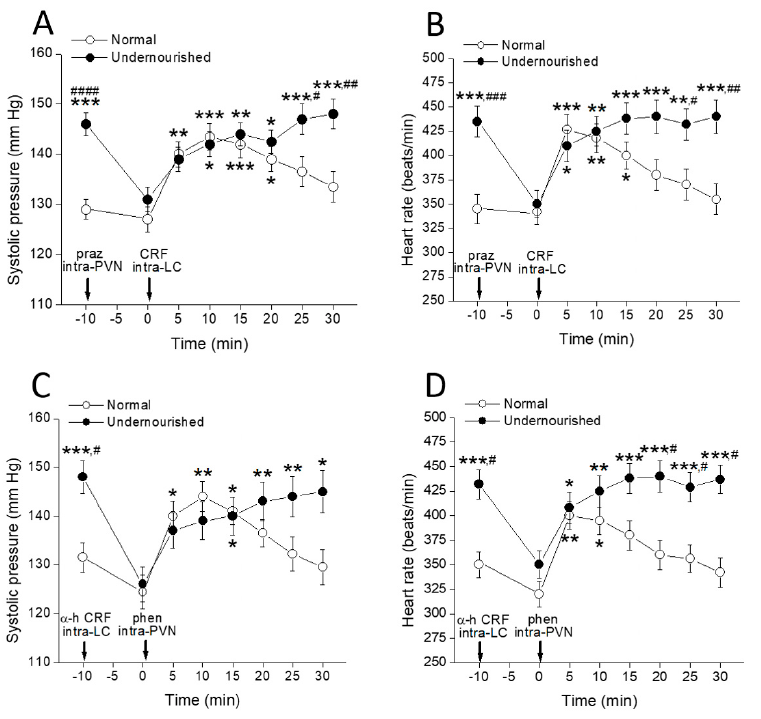
Figure 4. Time-course of changes in systolic pressure ( A , C ) and heart rate ( B , D ) of normal and prenatally undernourished rats after intra-PVN or intra-LC microinjection of phenylephrine (phen) or CRF (arrow at time 0 min), respectively, with or without pre-injection of an antagonist (praz or α -h CRF respectively, arrow at time − 10 min) into the complementary nucleus. Values are means ± SEM, n = six rats in each group. Two-way repeated measures ANOVA was used to identify the nutritional treatment and/or the time elapsed after drug microinjection as significant factors in the effect examined (( A ): effect on systolic pressure of CRF intra-LC preceded by prazosin intra-PVN, F nutrition(1, 10) = 28.02 and F time(7, 70) = 6.058; ( B ): effect on systolic pressure of phenyle- phrine intra-PVN preceded by α -helical CRF intra-LC, F nutrition(1, 10) = 15.90 and F time(7, 70) = 5.806; ( C ): effect on heart rate of CRF intra-LC preceded by prazosin intra-PVN, F nutrition(1, 10) = 11.33 and F time(7, 70) = 4.233; ( D ): effect on heart rate of phenylephrine intra-PVN preceded by α -helical CRF intra-LC, F nutrition(1, 50) = 31.43 and F time(7, 70) = 5.171). Significance symbols arising from the post hoc tests indicate either intragroup differences after drug treatment referred to the control at time = 0 min (* p < 0.05, ** p < 0.01, *** p < 0.001, Dunnett’s multiple comparisons test) or intergroup differences between normal and undernourished subjects ( # p < 0.05, ## p < 0.01, ### p < 0.001, #### p < 0.0001, Bonferroni’s multiple comparisons